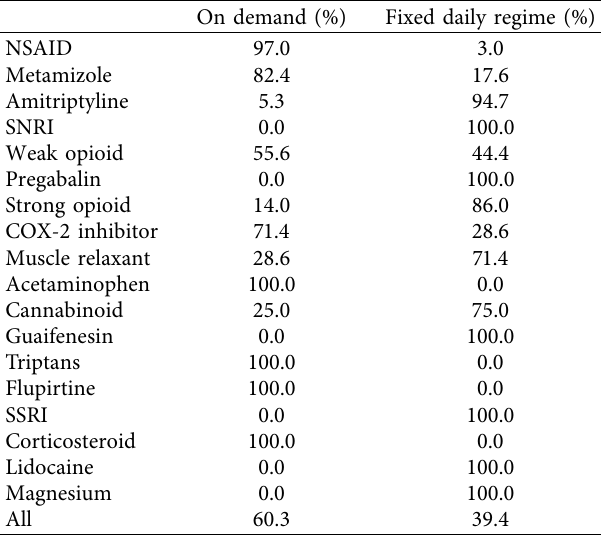
Table 2: Treatment regimens for each category of medication.